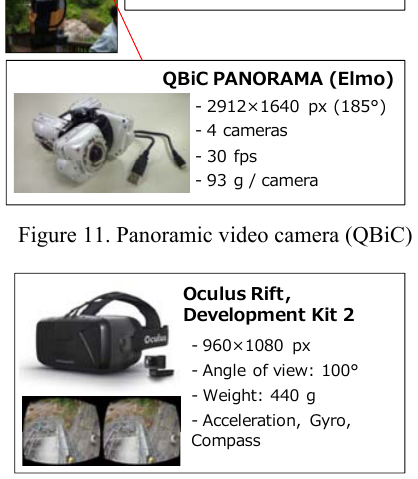
Figure 15. Point cloud acquired with terrestrial LiDAR